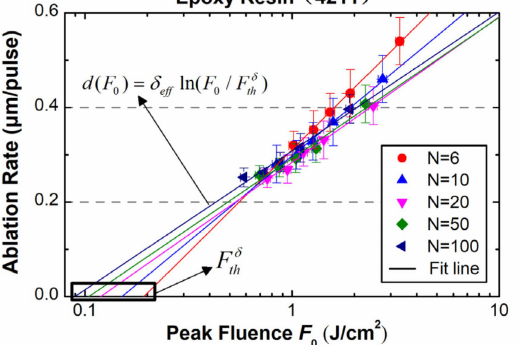
Figure 5. Ablation rate of the 4211 resin as a function of incident laser fluence at different pulse